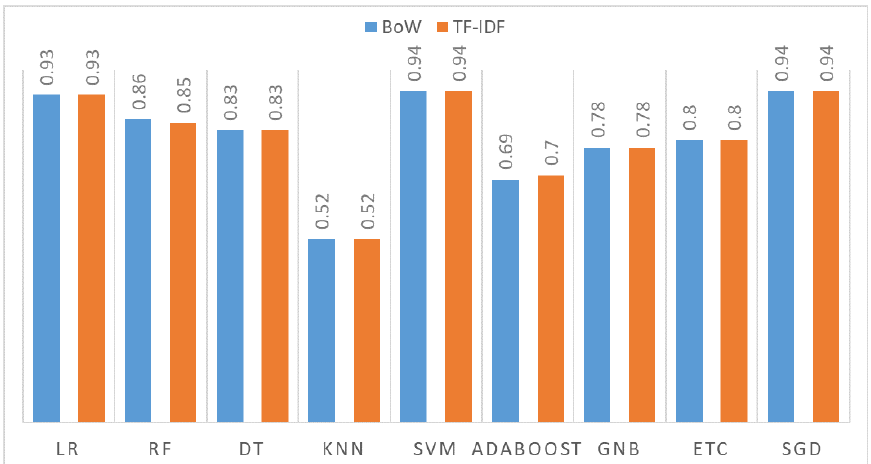
Figure 3. Models’ performance comparison using BoW and TF-IDF on the original imbalanced dataset.